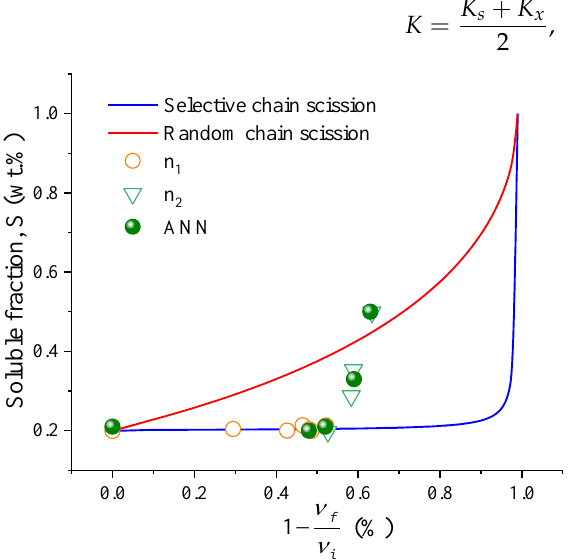
𝜈 𝑓 ) (Horikx analysis). The ) (Horikx analysis). 𝜈 𝑖 ν i